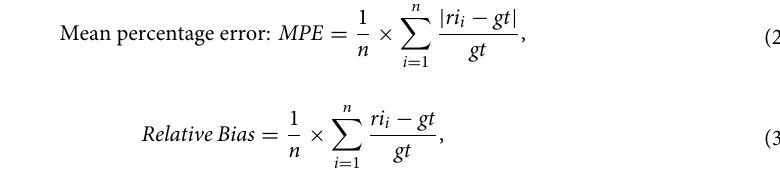
Figure 1. Flowchart of the refineR algorithm for the estimation of reference intervals from routine data. Based on the density of the observed routine data ( 1A ), the search regions for the parameters λ , μ and σ are derived. This information is employed to define a region around the main peak ( 1B ) where a histogram H of the data is calculated ( 1C , black dashed line). After that, a parametrical function M is employed to predict the expected values for each bin in H normalized with a factor P (estimated fraction of non-pathological samples) ( 2A , green line). An asymmetric confidence band around the expected values M ( 2B , green area) is utilized to identify the bins that then contribute to the calculation of the cost function ( LL ) ( 2B blue points). Using an optimization process ( 2C ), the parameters λ* , μ* , σ* , and P* resulting in the minimum costs are identified and used to estimate the distribution of non-pathological samples. The corresponding reference intervals are then derived using this estimated distribution ( 3